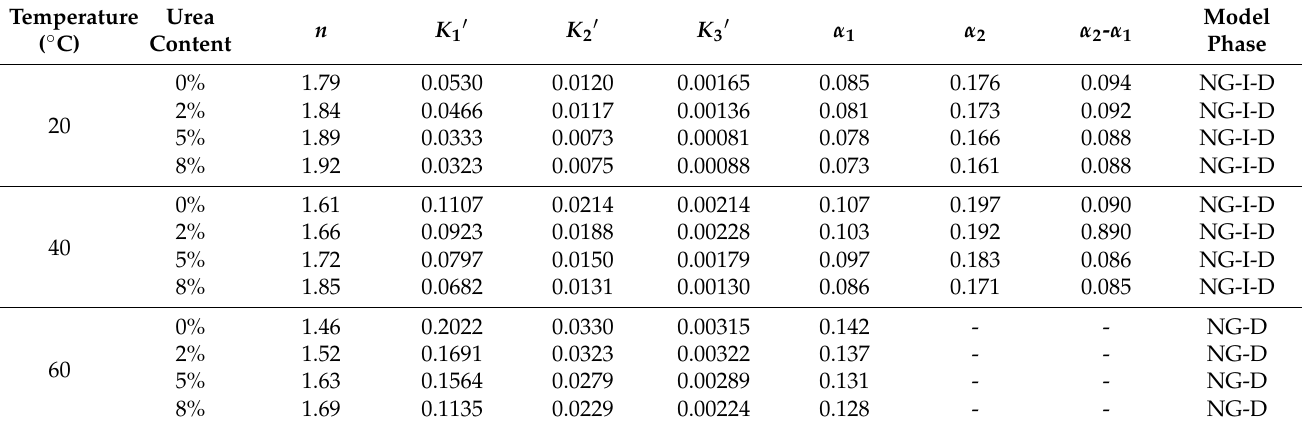
Table 5. Hydration kinetics